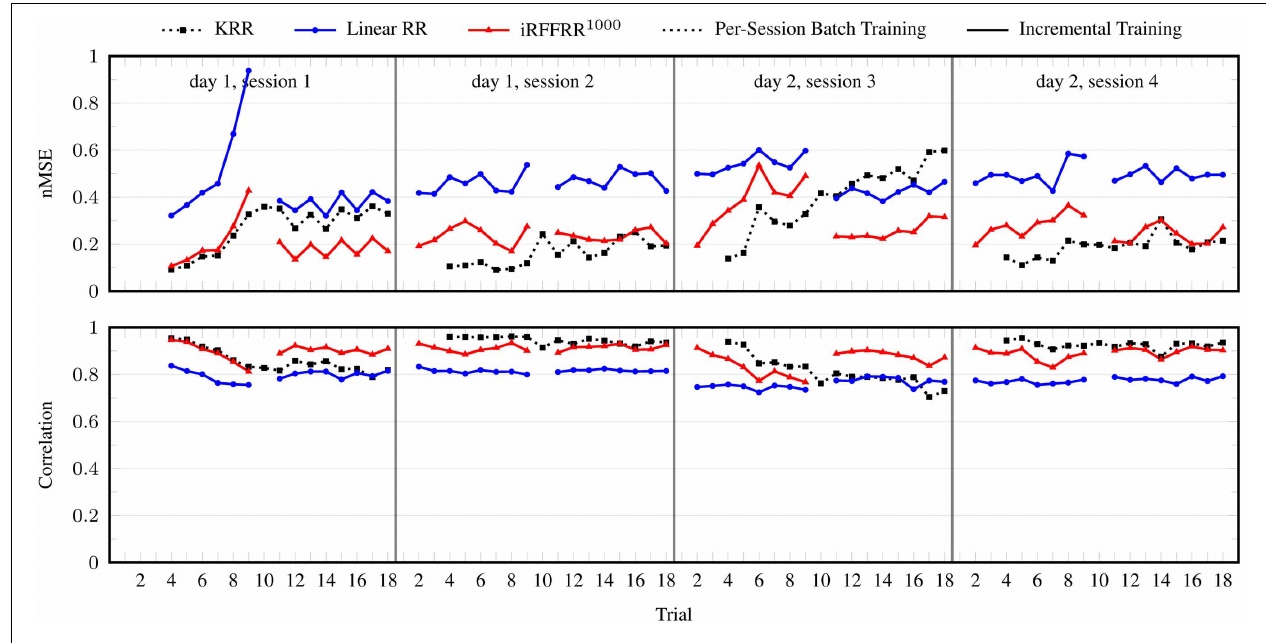
FIGURE 5 | nMSE and correlation coefficient per trial, in the incremental setting. For comparison, the results for KRR trained per session are also included. The presented results for the linear method